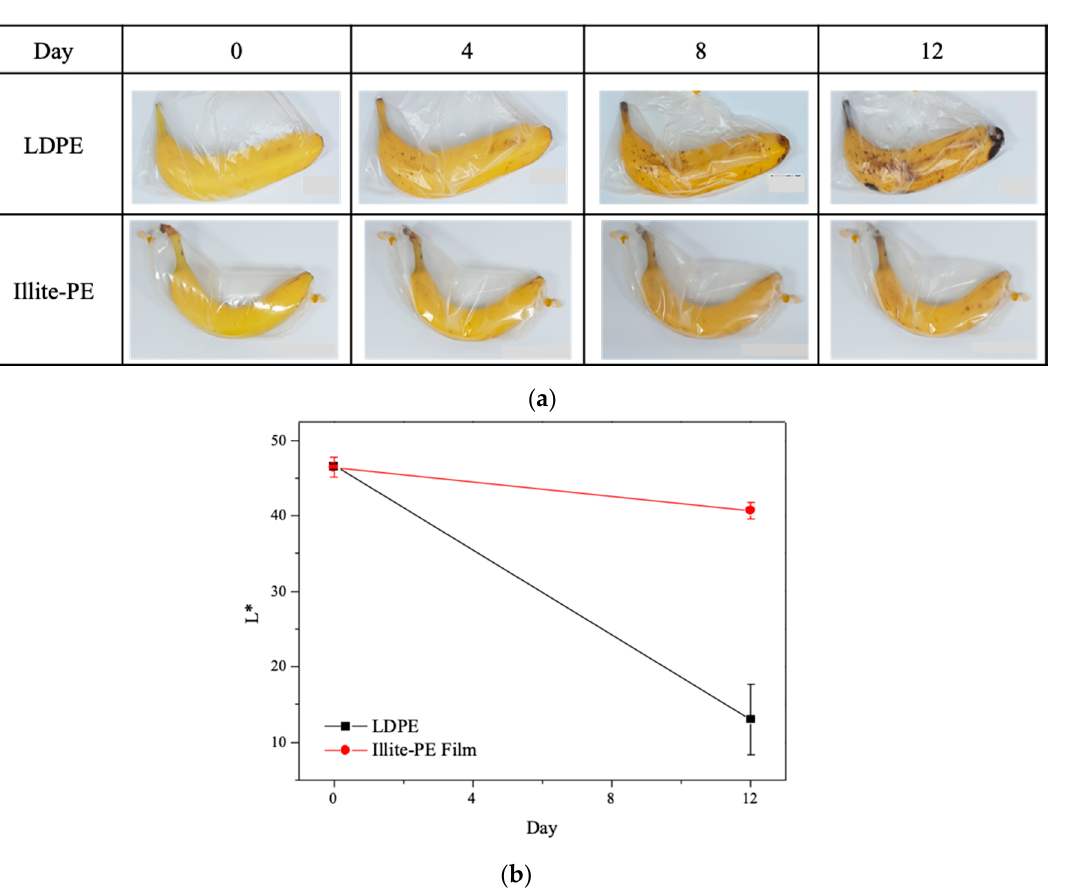
Figure 5. In vitro cytotoxicity of illite material and illite-PE film (negative control; high density. polyethylene film, positive control; 0.1 % ZDEC polyurethane film).